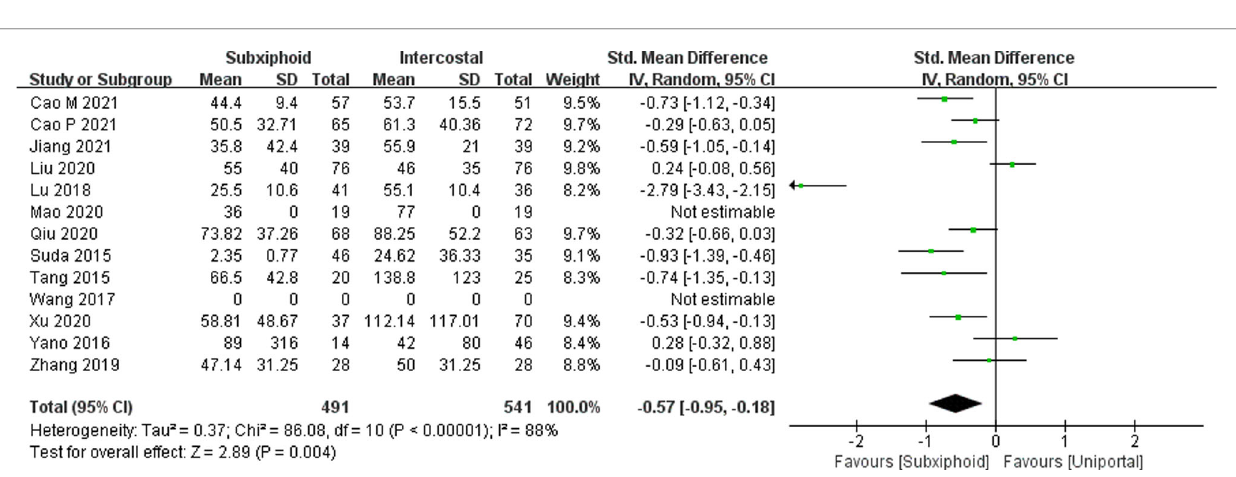
FIGURE 6 | Forest plot of the role of SMD and its 95% CI of blood loss between SVATS and IVATS groups.